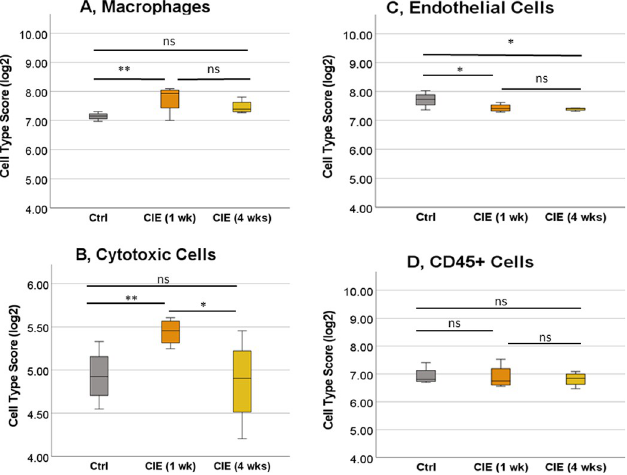
Fig 5. Differential expression of the genes in cell types present in the bladder wall. Cell type scores were significantly different between the control and experimental groups for several populations of the cells including macrophages (A), cytotoxic cells (B) and endothelial cells (C). No significant change in gene expression between the groups was noted for CD45 + cells (D). N = 4 for each group. � p � 0.05, �� p � 0.01.